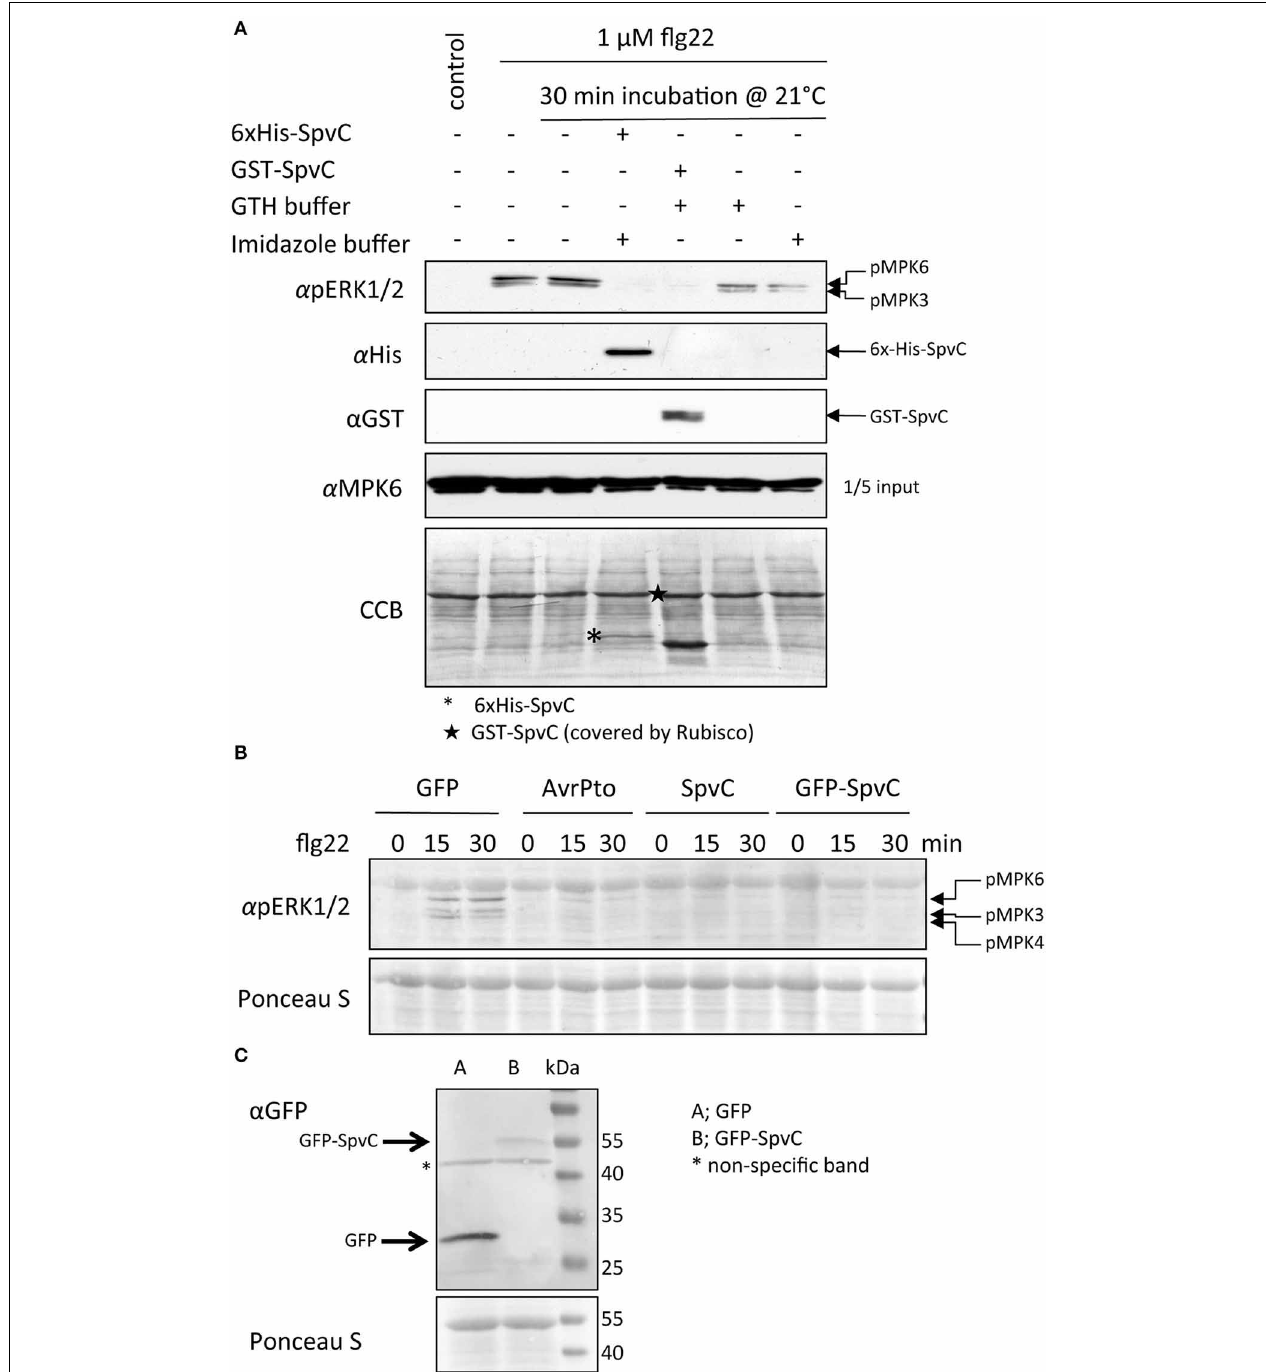
FIGURE 5 | Active MAPKs are dephosphorylated by SpvC. (A) MAPKs were activated by treatment of 2-week old seedlings with flg22 for 20 min prior to the extraction of total soluble proteins. Extracted proteins were then incubated for 30 min with purified recombinant 6xHis-SpvC or GST-SpvC proteins. The phosphorylation status of Arabidopsis MAPKs was analyzed by immunoblotting using an antibody raised against the phosphorylated form of EKR1/2 ( α pERK1/2). The recombinant proteins were probed with anti-His and anti-GST antibodies ( α His and α GST, respectively). Specific anti-MPK6 ( α MPK6) antibody was used to assess the presence of MPK6. CCB stain was